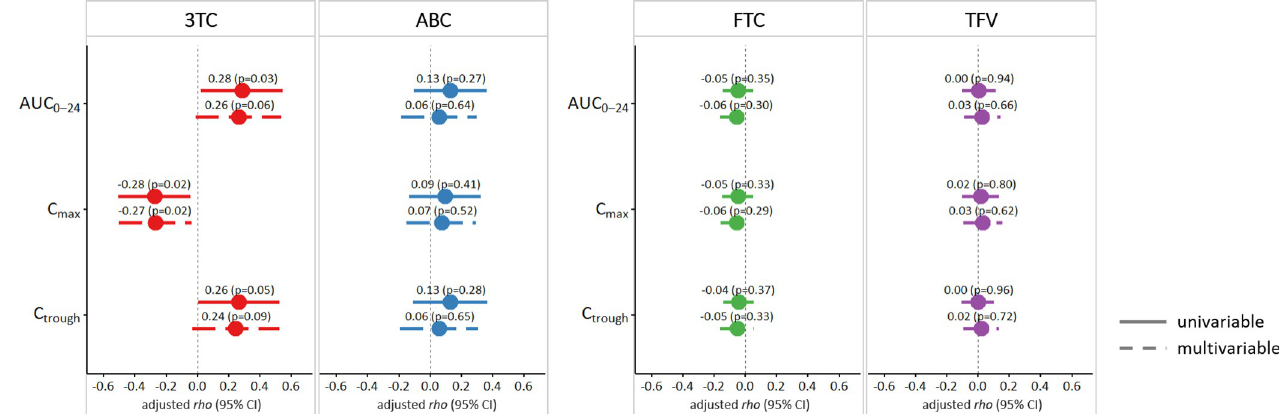
Fig 1. Regression coefficients (i.e. adjusted rho) from rank regression evaluating the associations of PK parameters with global z-scores. Associations are adjusted for age, gender, ethnicity, education, estimated glomerular filtration rate, use of ritonavir/cobicistat boosted protease inhibitor and use of efavirenz (3TC and ABC PK parameters), plus BMI (for FTC and TFV PK parameters only). Univariable estimates: one NRTI at the time in separate models; multivariable estimates: both NRTIs in the regimen in the same model (one model for each PK parameter).